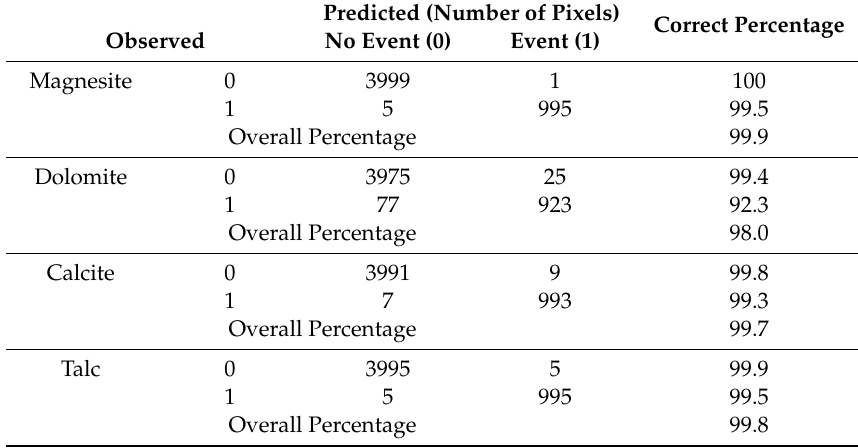
Predicted (Number of Pixels)